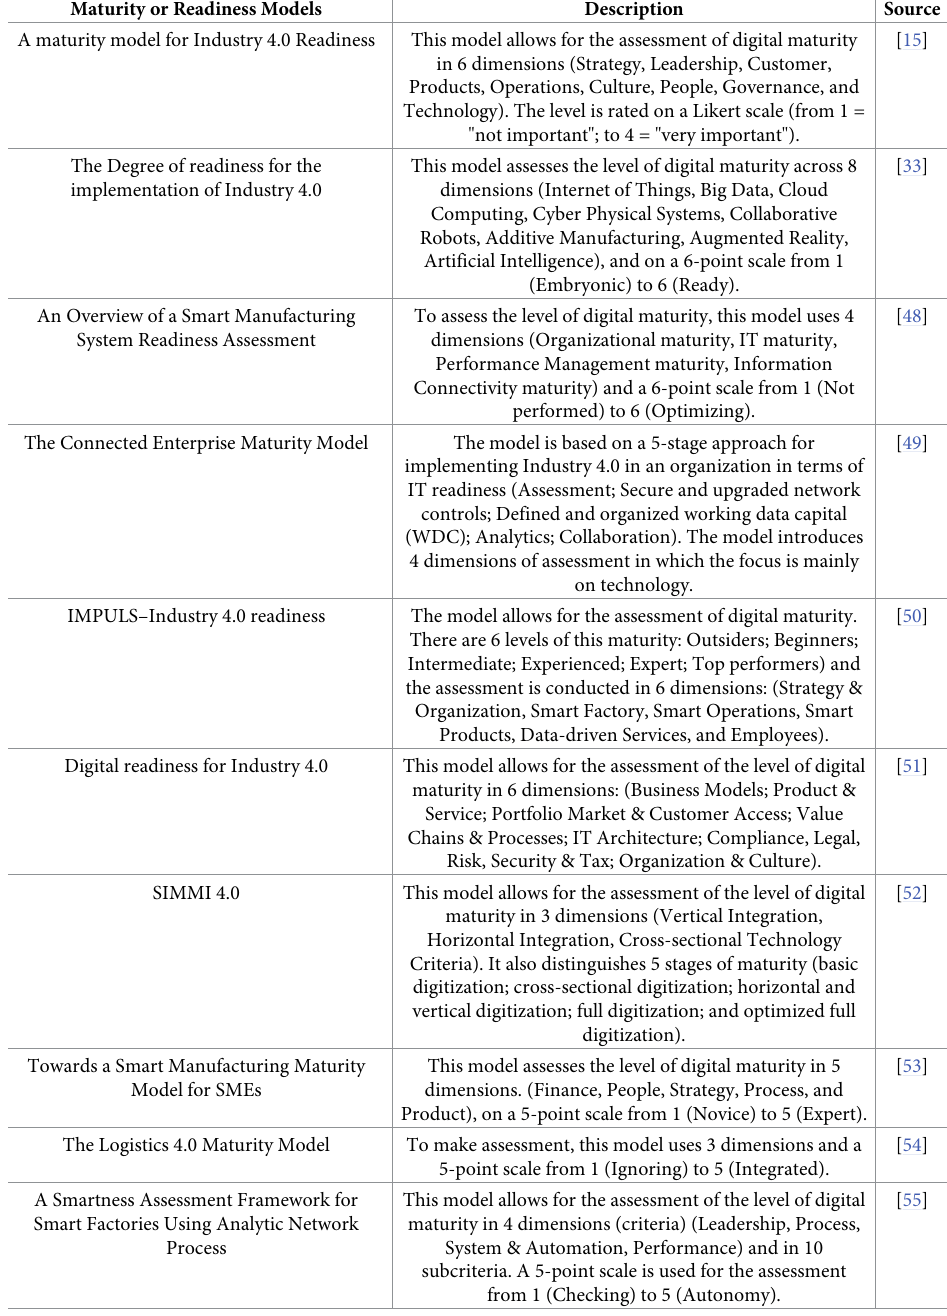
Table 2. Maturity and readiness